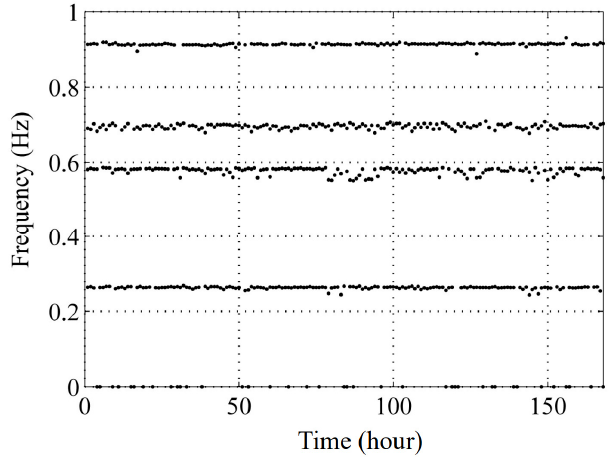
Figure 8. The identified frequencies along time with the unit hour.